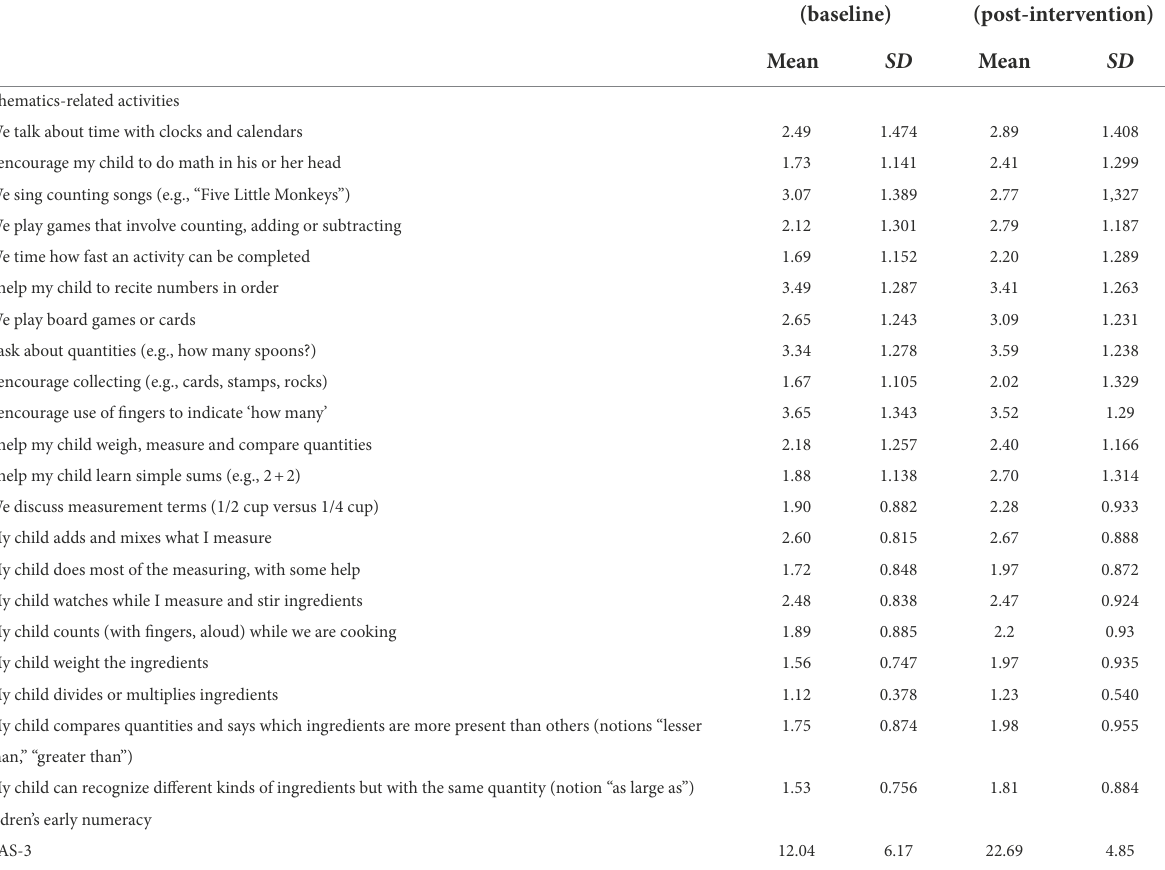
TABLE 1 Raw scores of parent-reported frequency of mathematics-related home activities and children’s early numeracy at Wave 1 (baseline) and Wave 2